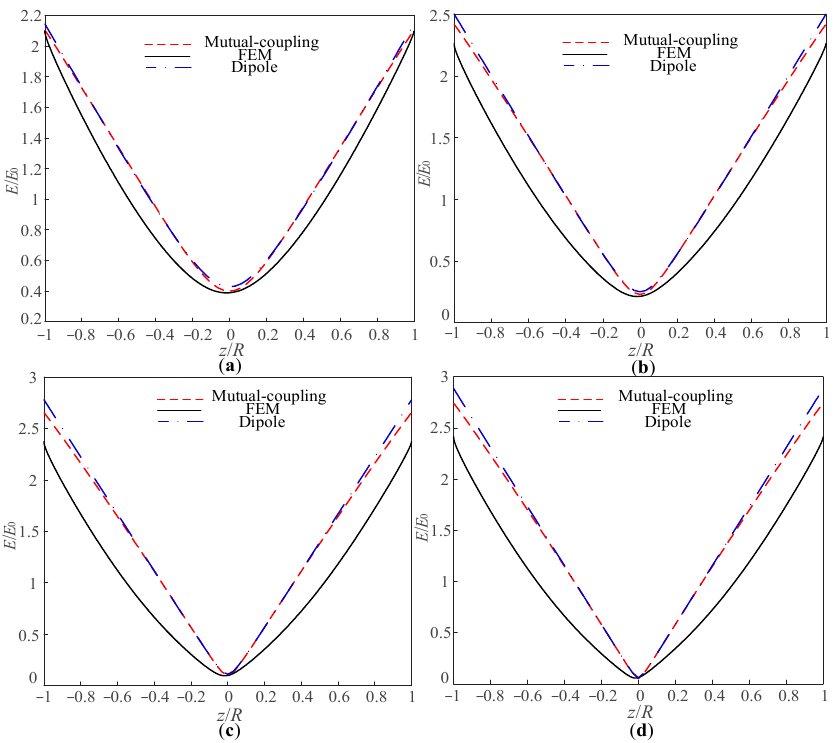
Figure 11. Calculation results of the electric field distribution on particle 1 when D / R = 1: ( a ) Calcu- lation results when ε i / ε e = 5; ( b ) Calculation results when ε i / ε e = 10; ( c ) Calculation results when ε i / ε e = 25; ( d ) Calculation results when ε i / ε e = 50.